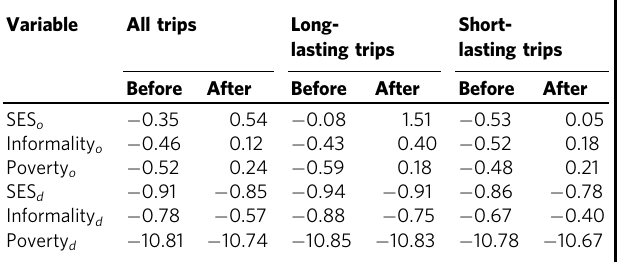
Note: The estimated differences are between the SES 1 and 6, the minimum and maximum shares of informal workers observed (14% and 70%), and the minimum and maximum levels of poverty observed (2.15 and 29.26). See Tables SI.2 and SI.3.